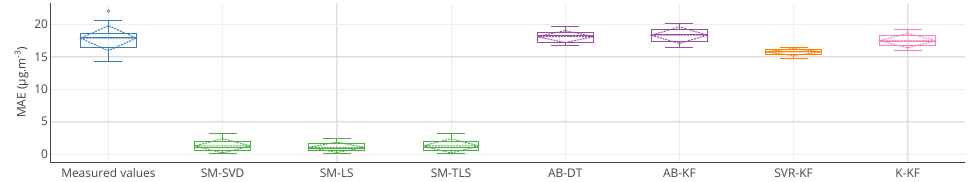
Figure 9. Box plots of the MAE, computed on the entire time interval of drift, of the 16 nodes of the network without calibration and with SM-SVD. It is a graphical representation of the information displayed in Table 1 for MAE. Supplementary information is provided compared to the table: quartiles, minimum and maximal values.